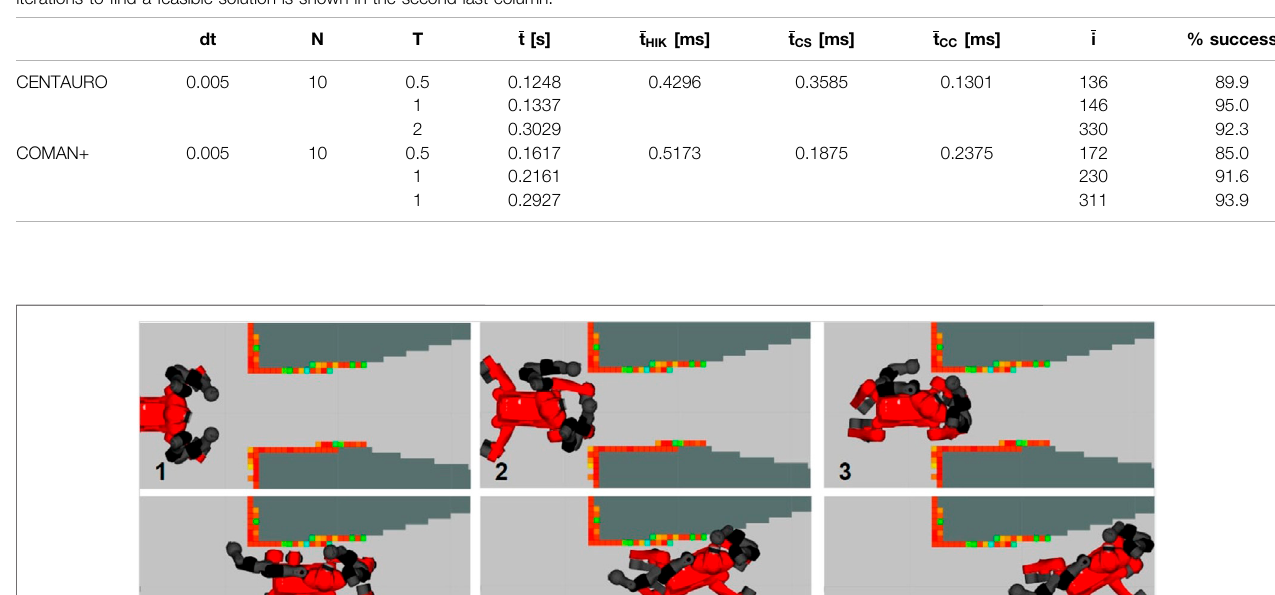
Frontiers in Robotics and AI |